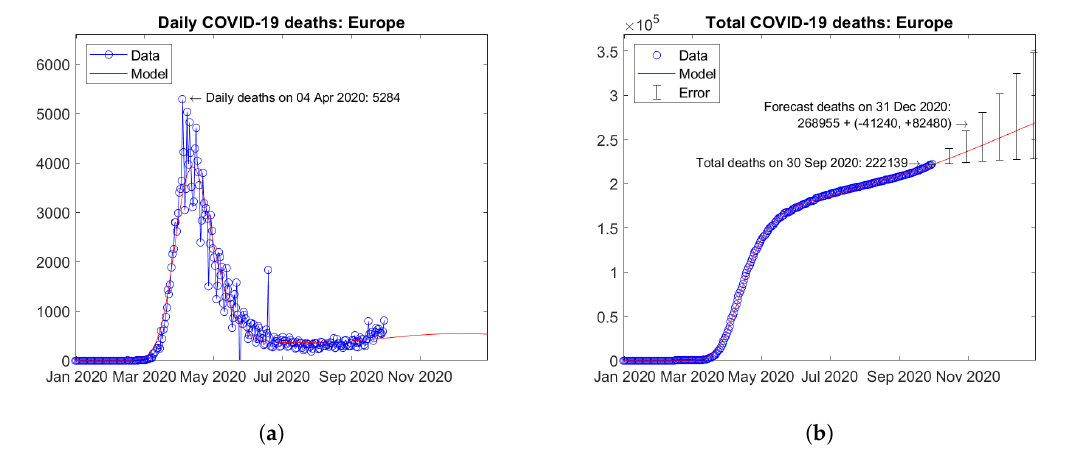
Figure 16. Actual and predicted trends in Europe: ( a ) total deaths; ( b ) daily deaths.